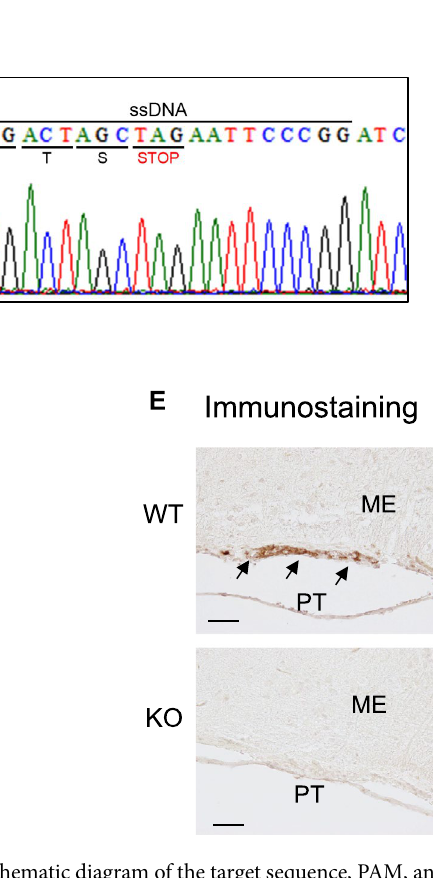
Figure 1. Generation of NMU-deficient rats. ( A ) Schematic diagram of the target sequence, PAM, and ssDNA at the Nmu gene locus. ( B ) Genome sequence of the mutation in the Nmu mutant allele. ( C ) Efficiencies of rat Nmu gene editing by the rGONAD method. ( D ) Genotyping of Hetero, WT, and KO performed by PCR. A representative gel image of genomic PCR products amplified from the indicated genotypes is shown. ( E ) Immunostaining of NMU in WT and NMU KO rat. The light micrograph is representative of IHC staining with the anti-NMU antibody in a frontal section of the brain. Positive signals are indicated by arrows. Scale bar: 50 µm. PT, pars tuberalis; ME, median eminence. See also Supplementary Figure